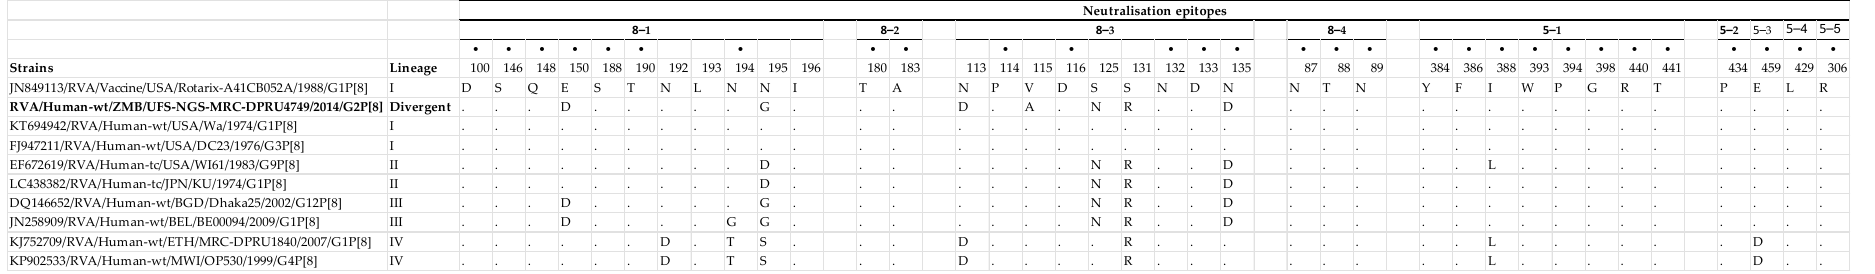
Figure 3. Alignment of the VP4 antigenic epitopes of the divergent study strain, UFS-NGS-MRC-DPRU4749 that is highlighted in bold, along with global P[8] strains belonging to the already defined four different P[8] lineages, in relation to Rotarix ® . Antigenic epitopes are divided into two subunits: VP8* (8-1 to 8-4) and VP5* (5-1 to 5-5). The bold black dots ( • ) indicate amino acid changes in the residues that have been shown to escape neutralisation with monoclonal antibodies. The normal dots (.) represent conserved amino acids relative to Rotarix ® .